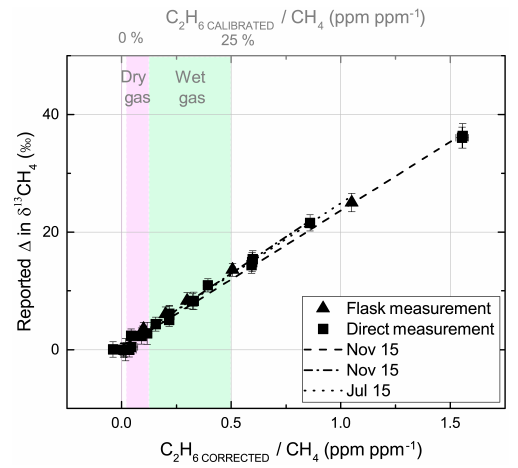
Figure 9. The effect of C 2 H 6 on reported δ 13 CH 4 . The slopes of re- ported δ 13 CH 4 vs. the C 2 H 6CORRECTED :CH 4 ratio are shown for three tests taken throughout the course of 1 year. Triangular markers imply whole-air sample measurements, while square markers are derived from direct measurements. Error bars indicate the standard deviation. In the presence of C 2 H 6 the instrument reports heavier values of δ 13 CH 4 . The typical range of (calibrated) C 2 H 6 :CH 4 of dry and wet gas are highlighted in pink and green respectively, cor- responding to the top